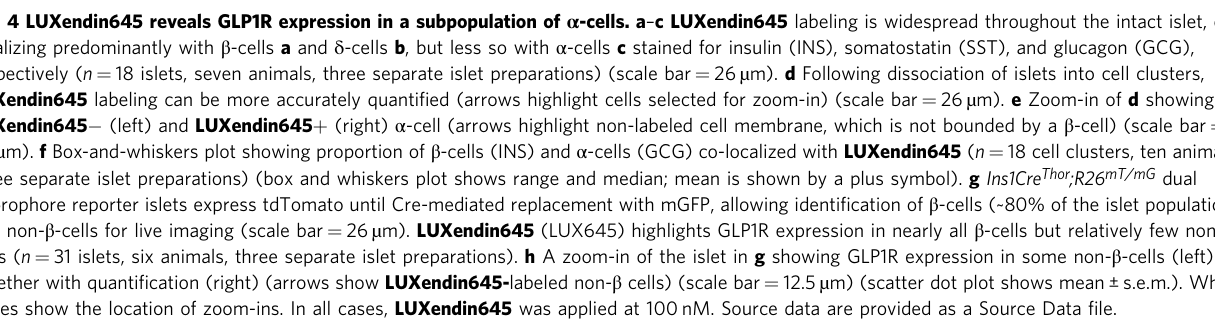
Fig. 4 LUXendin645 reveals GLP1R expression in a subpopulation of α -cells. a – c LUXendin645 labeling is widespread throughout the intact islet, co- localizing predominantly with β -cells a and δ -cells b , but less so with α -cells c stained for insulin (INS), somatostatin (SST), and glucagon (GCG), respectively ( n = 18 islets, seven animals, three separate islet preparations) (scale bar = 26 µ m). d Following dissociation of islets into cell clusters, LUXendin645 labeling can be more accurately quanti fi ed (arrows highlight cells selected for zoom-in) (scale bar = 26 µ m). e Zoom-in of d showing a LUXendin645 − (left) and LUXendin645 + (right) α -cell (arrows highlight non-labeled cell membrane, which is not bounded by a β -cell) (scale bar = 26 µ m). f Box-and-whiskers plot showing proportion of β -cells (INS) and α -cells (GCG) co-localized with LUXendin645 ( n = 18 cell clusters, ten animals, three separate islet preparations) (box and whiskers plot shows range and median; mean is shown by a plus symbol). g Ins1Cre Thor ;R26 mT/mG dual fl uorophore reporter islets express tdTomato until Cre-mediated replacement with mGFP, allowing identi fi cation of β -cells (~80% of the islet population) and non- β -cells for live imaging (scale bar = 26 µ m). LUXendin645 (LUX645) highlights GLP1R expression in nearly all β -cells but relatively few non- β - cells ( n = 31 islets, six animals, three separate islet preparations). h A zoom-in of the islet in g showing GLP1R expression in some non- β -cells (left) together with quanti fi cation (right) (arrows show LUXendin645- labeled non- β cells) (scale bar = 12.5 µ m) (scatter dot plot shows mean ± s.e.m.). White boxes show the location of zoom-ins. In all cases, LUXendin645 was applied at 100 nM. Source data are provided as a Source Data fi